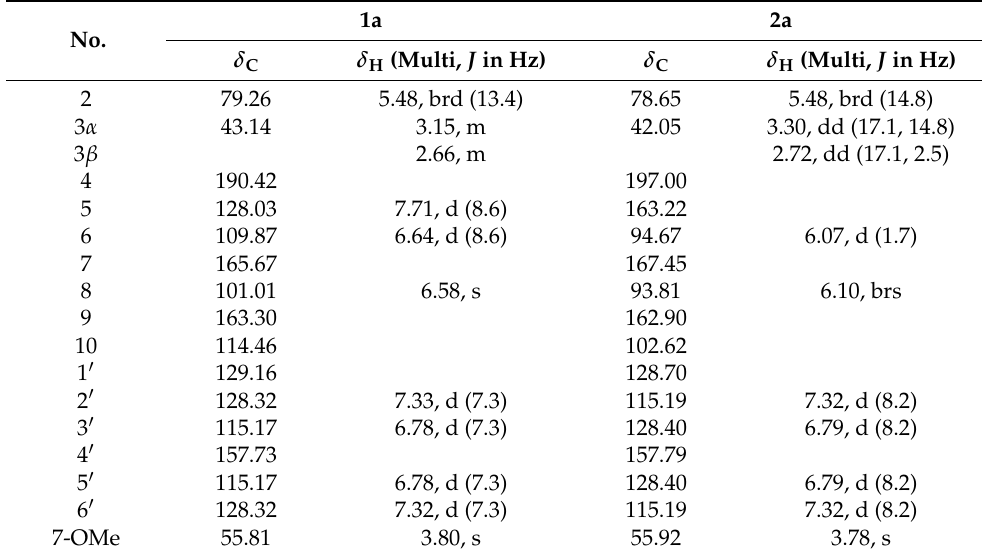
Table 2. 1 H (600 MHz) and 13 C NMR (150 MHz) data of 1a and 2a in DMSO- d 6 .